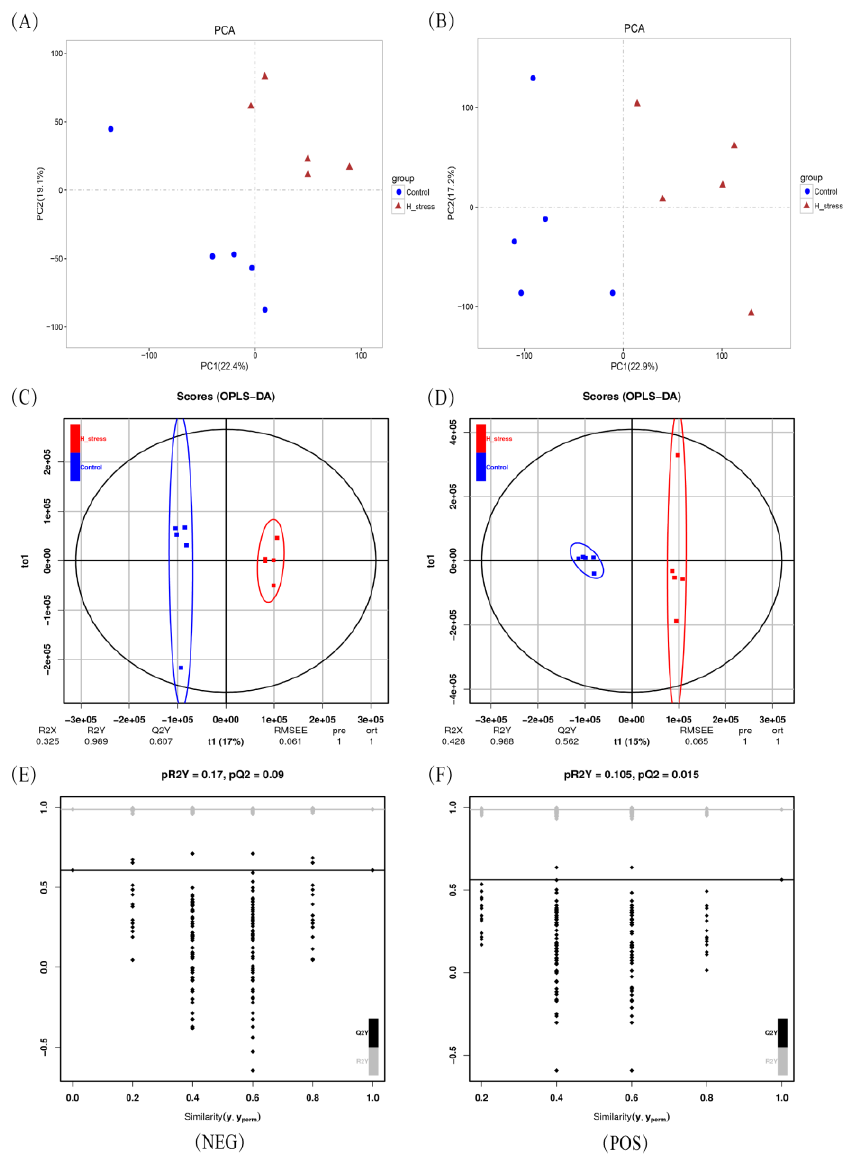
Figure 2. Metabolomic analysis of PCA score map, OPLS-DA score plot and permutation test of OPLS-DA. Control group (incubation at 37 ◦ C, n = 5) and treatment group (incubation at 42 ◦ C, n = 5). Multivariate analysis of ( A , C , E ) was performed base on negative ion (NEG) mode, while the multivariate analysis (fixed effect = temperature, random effect = culture plate) of ( B , D , F ) was performed based on positive ion mode (POS). PCA = principal component analysis, the blue represent control, and the red represent heat stress. OPLS-DA = orthogonal partial least squares discriminant analysis, the blue represents control, and the red represents heat